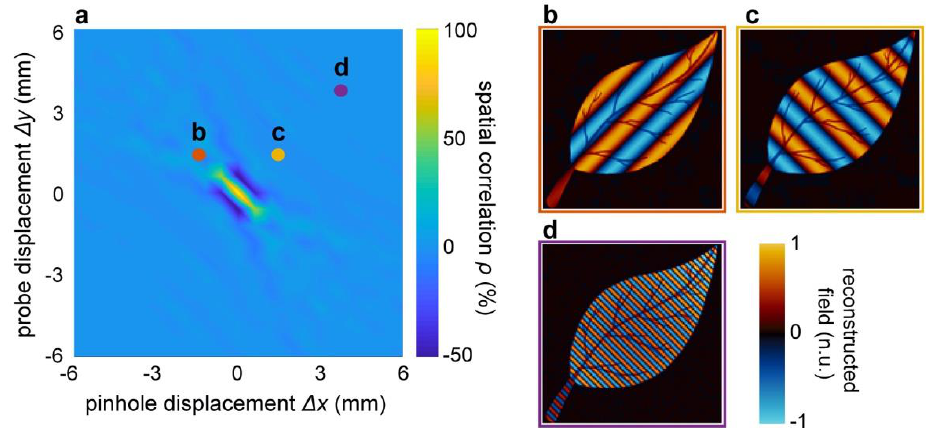
Figure 4. Influence of the pinhole displacement on the Fourier detection of TIMING reconstruction coefficients. ( a ) Spatial correlation between the reconstructed and original image as a function of the sampling function positioninthefocalplane. Thedisplacement ( ∆ x, ∆ y) wasmeasuredwithrespecttothelensaxisandthesampling functiondiameterwassetto d = 0.36mm,correspondingtoaspatialcorrelationof100%atthecentreoftheFourier plane (cf. Figure 3e). ( b – d ) Examples of image reconstruction with off-axis detection, illustrating the appearance of spurious spatial frequencies. Interestingly, the object morphology was still noticeable, even at a relatively large distance from the optical